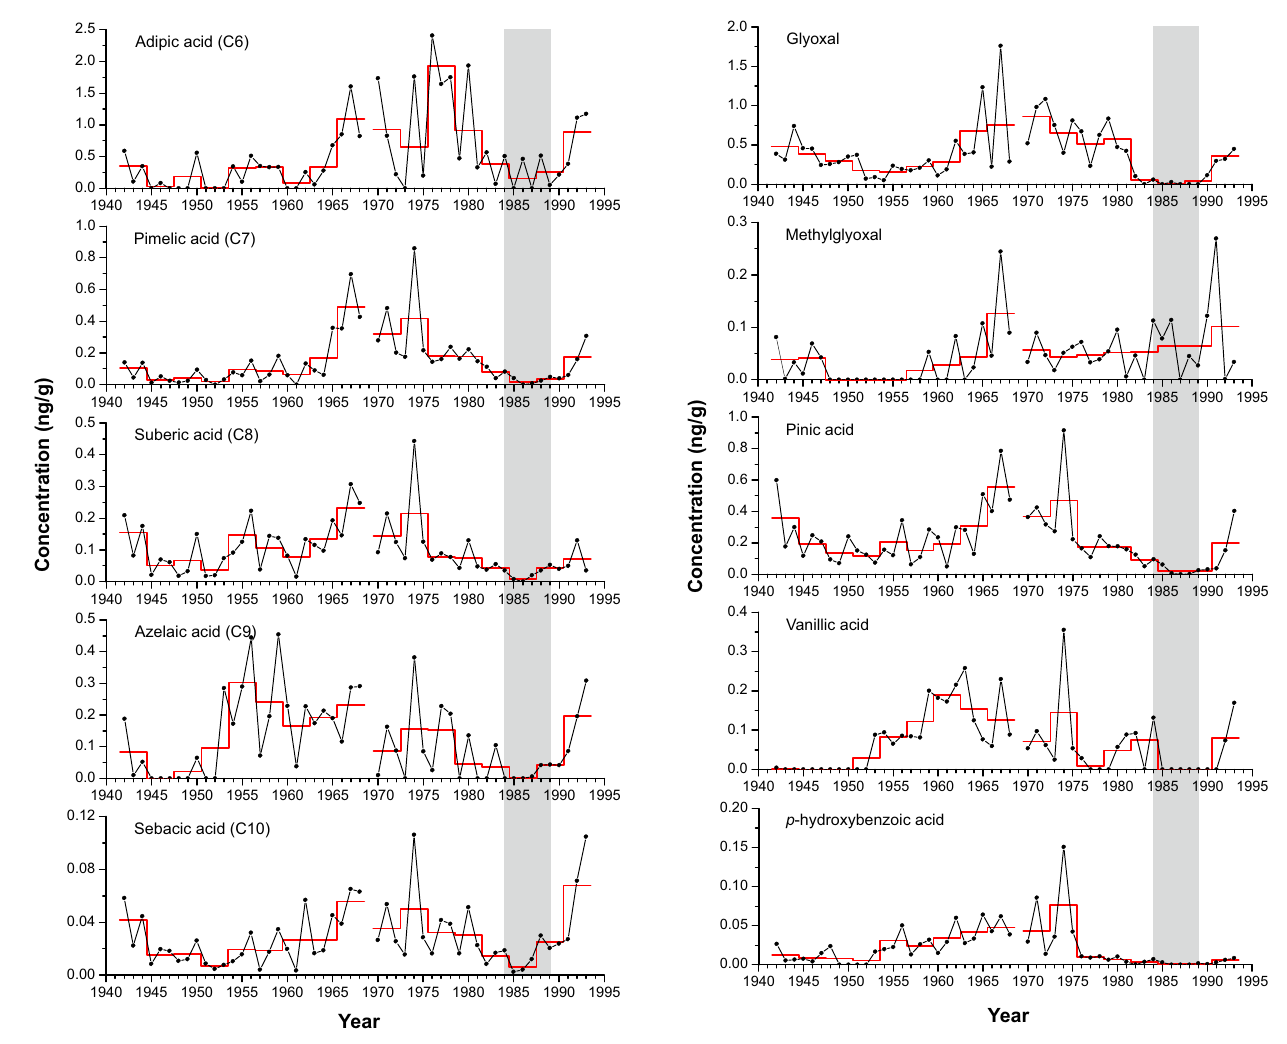
Figure 3. Ice core records of dicarboxylic acids C 6 –C 10 in the Alpine ice core from upper Grenzgletscher (black dots: annual aver- ages, red line: 3-year averages). The period influenced by meltwater (1984–89) is marked in gray.